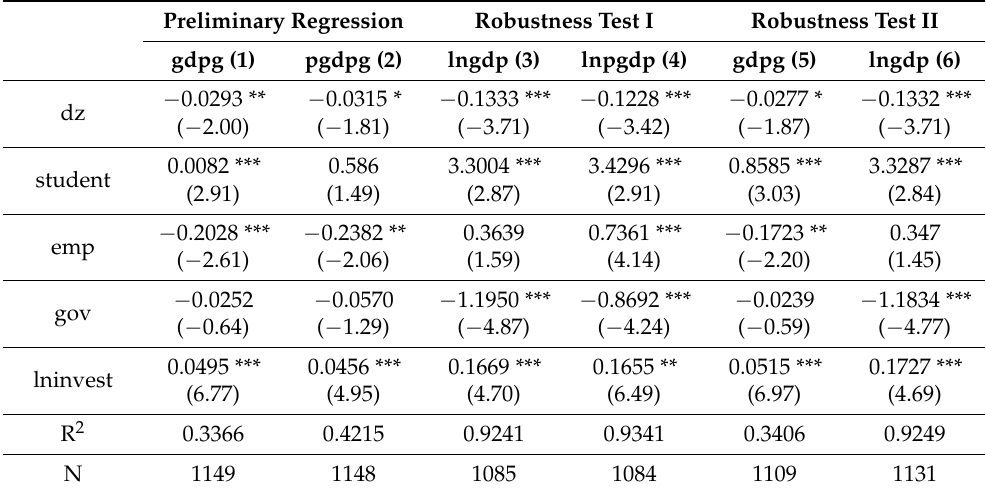
Table 5. Impact of development zones on economic growth: preliminary regression and robustness